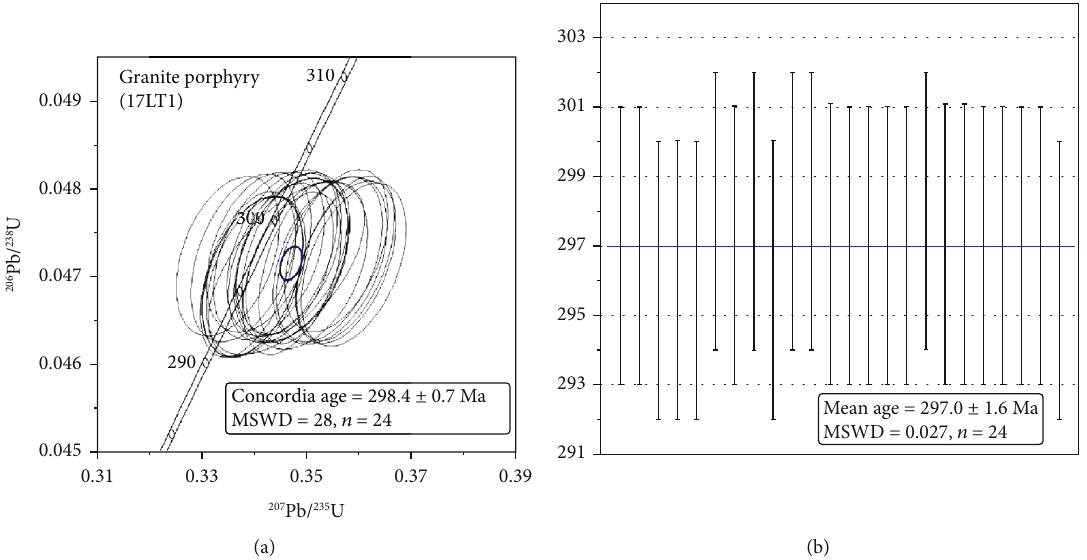
Figure 7: The U-Pb concordant diagram and the weighted average age of zircons from granite porphyry in the Tieling